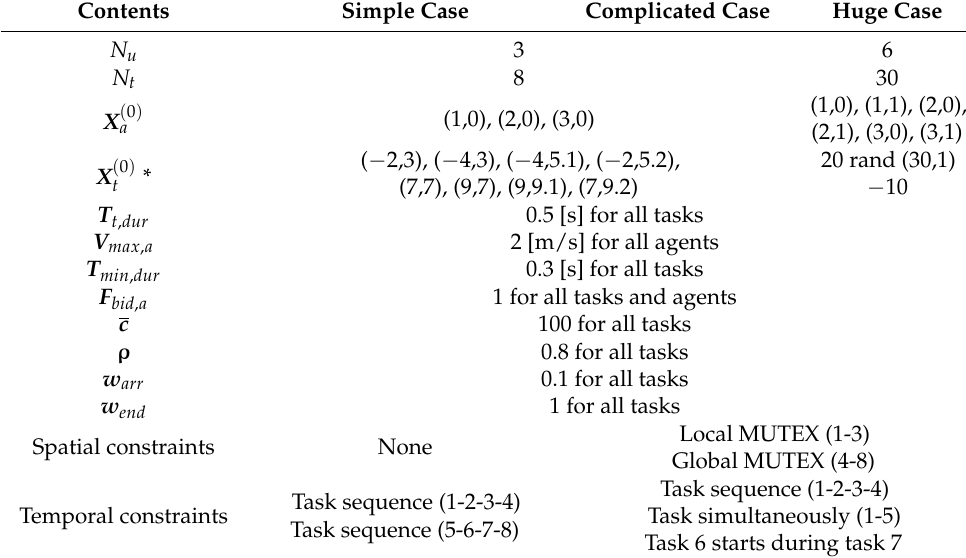
Table 13. Settings for